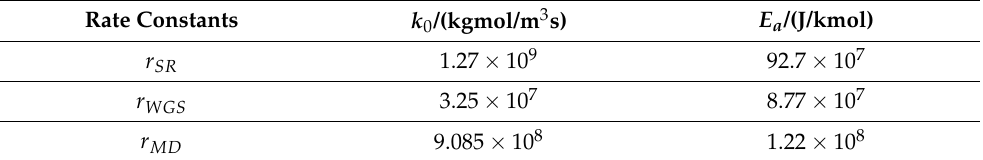
Table 2. Kinetic constants for the overall methanol–steam-reforming